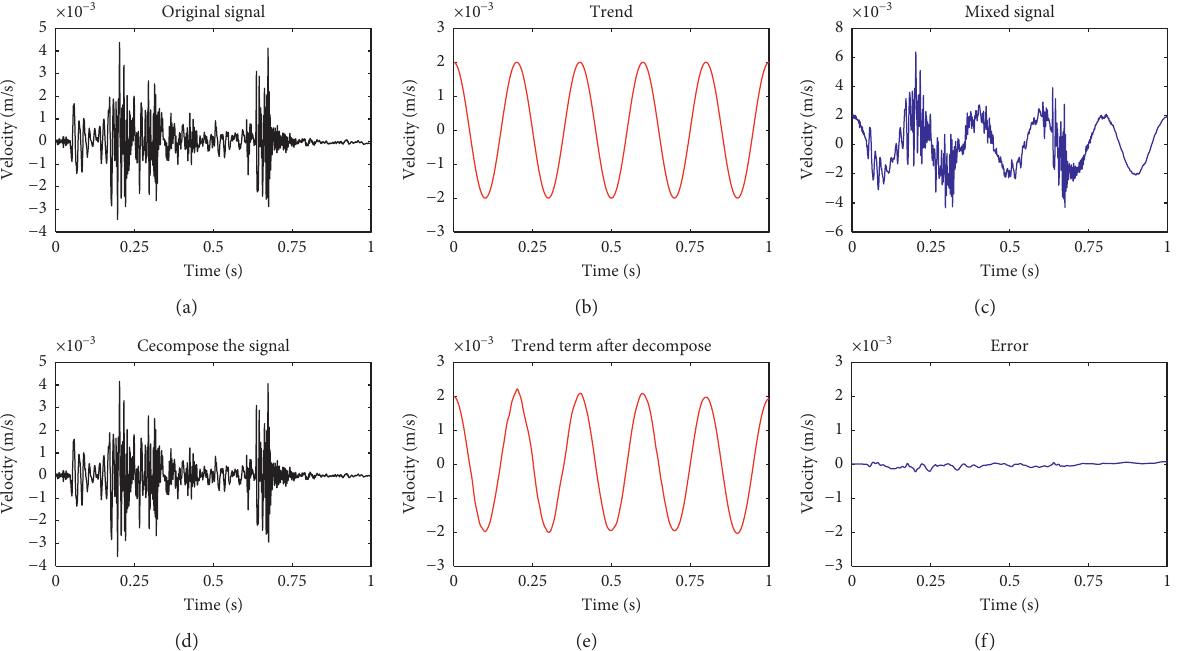
Figure 4: No trend blasting vibration signal. (a) Original signal. (b) Trend. (c) Mixed signal. (d) Decomposing the signal. (e) Trend term after decompose. (f)